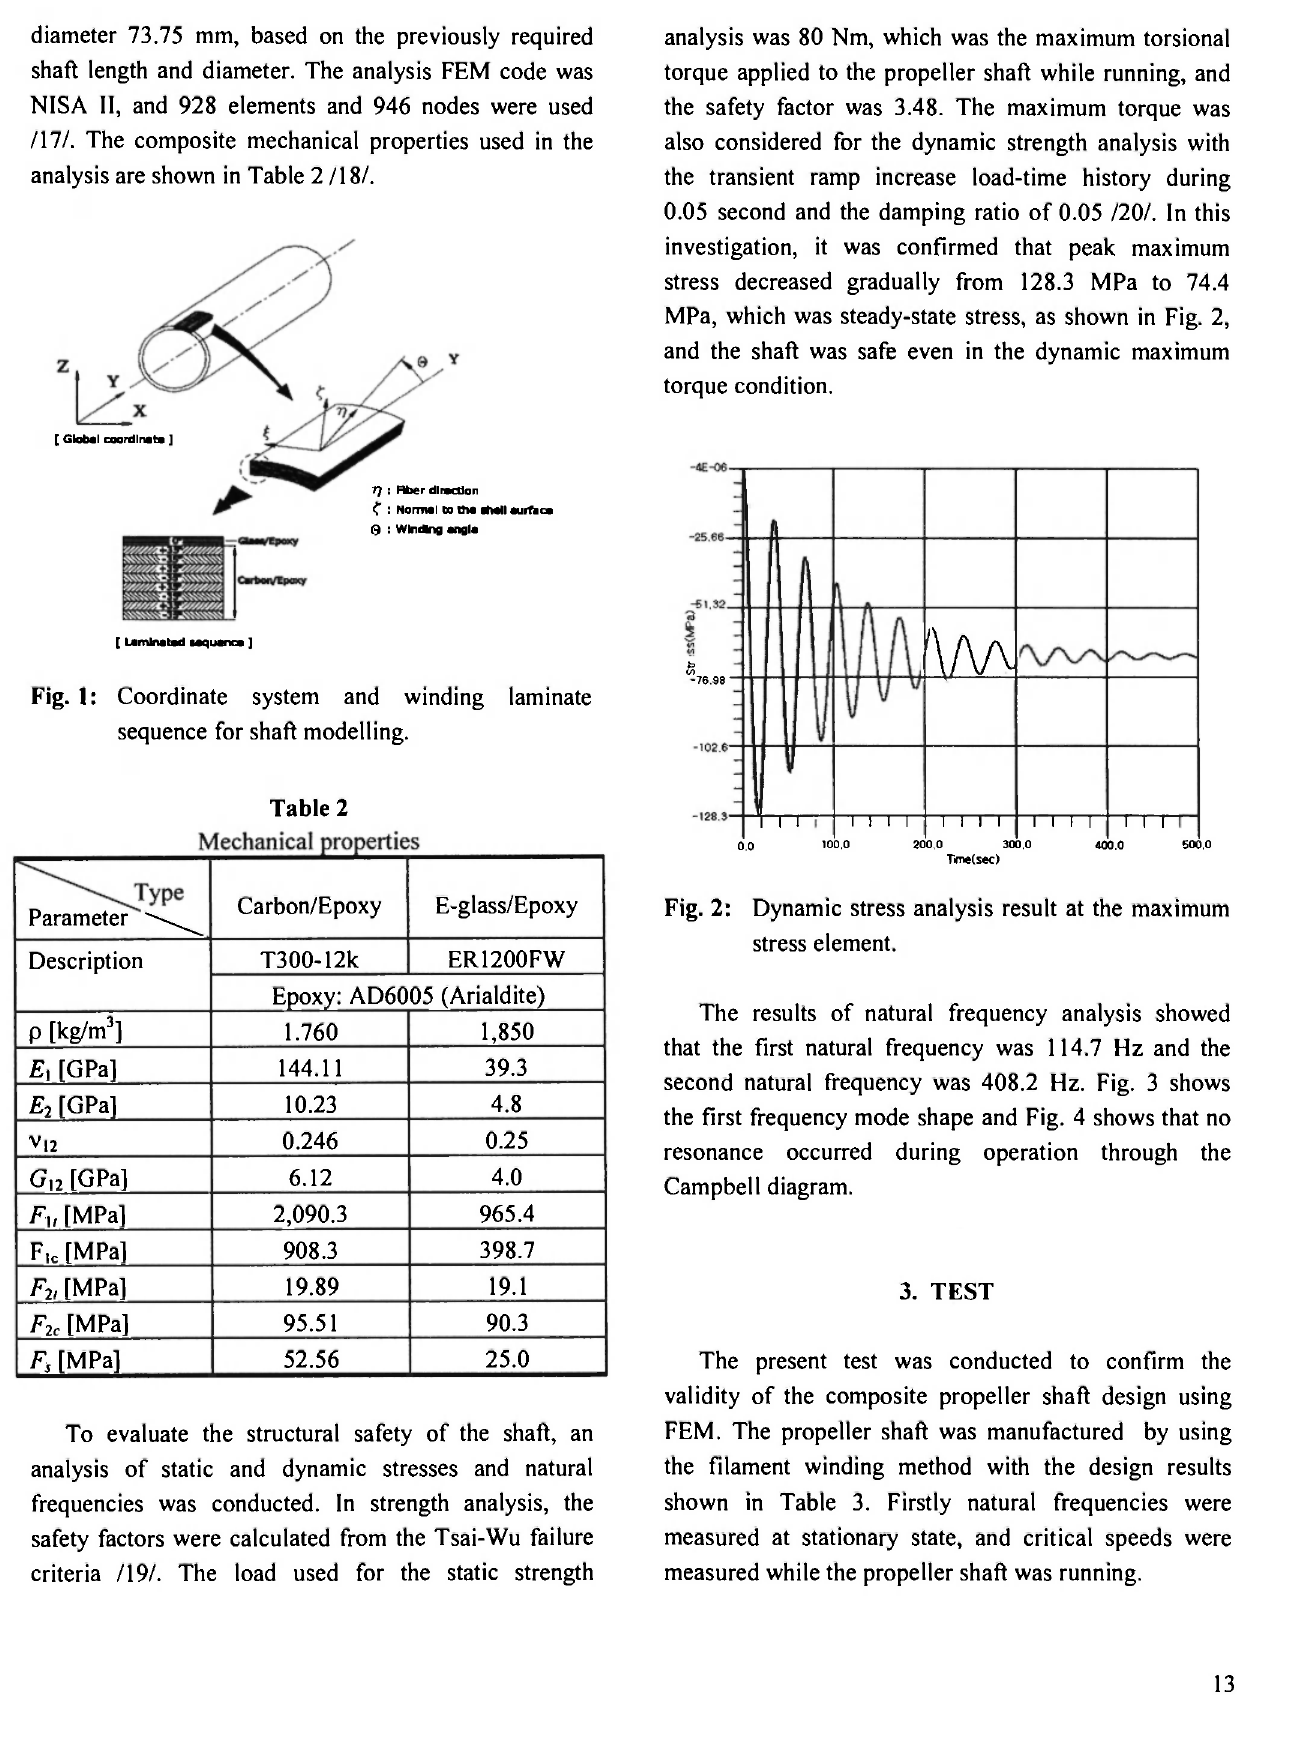
Fig. 1: Coordinate system and winding laminate sequence for shaft modelling.